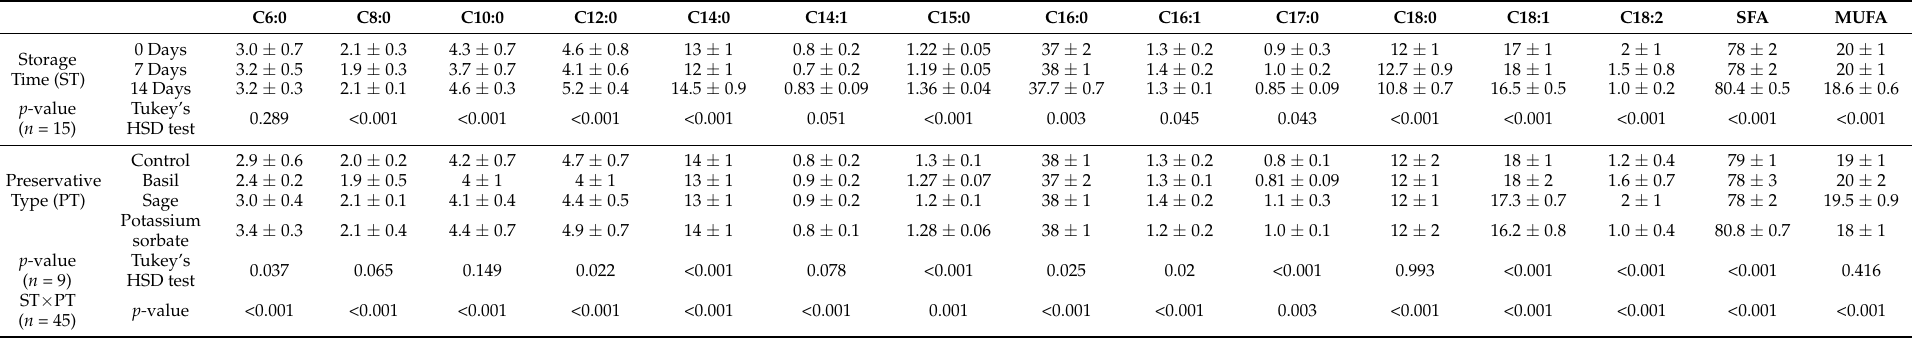
Table 4. Individual fatty acids profile, as well as total saturated fatty acids (SFA) and monounsaturated fatty acids (MUFA) found in the yogurts, expressed as relative percentage.